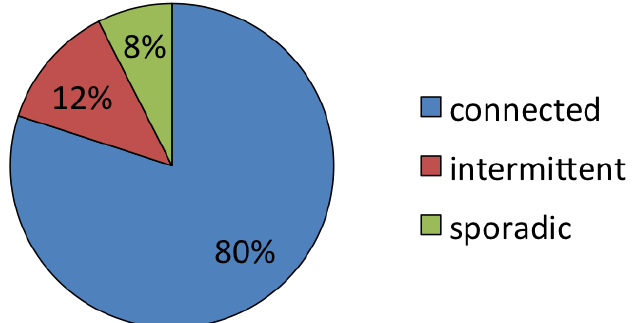
Figure 6. Deployment network connectivity —Eighty percent of deployments consider a network to be continuously connected, while only 12% experience significant disconnections and 8% use opportunistic communication.